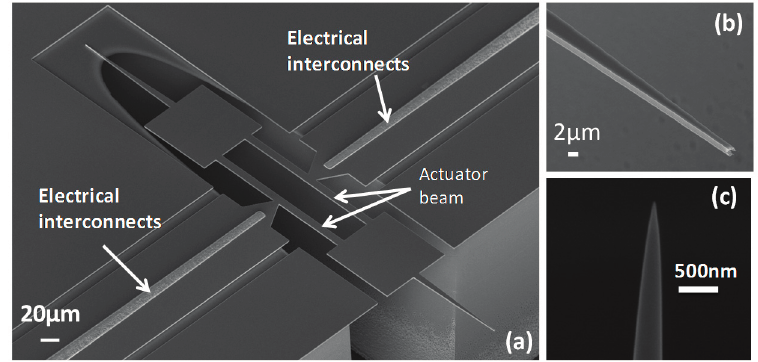
Figure 4. SEM images of ( a ) Overview of fabricated device; ( b ) Close view of the 150 µm long and 10 µm wide massif tip; ( c ) Tip sharpened by Focused Ion Beam